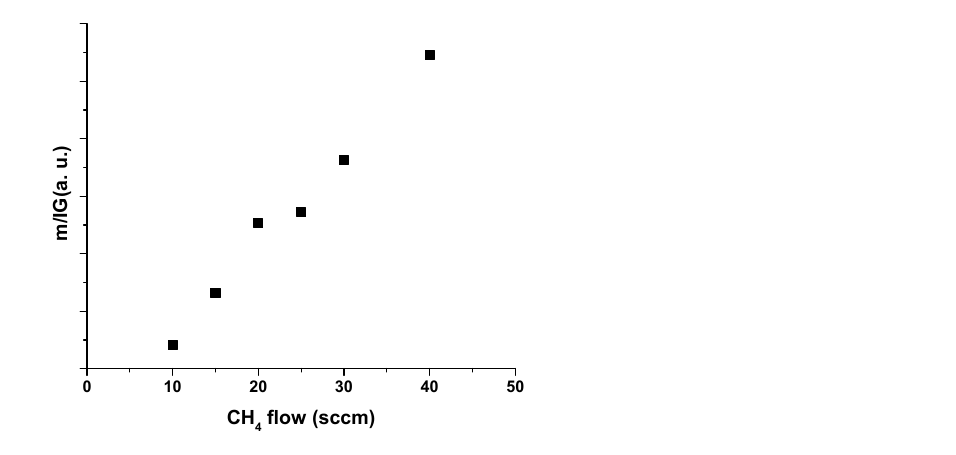
Figure 2. Evolution of m/IG with methane flow rate for the a-C(W):H coatings.